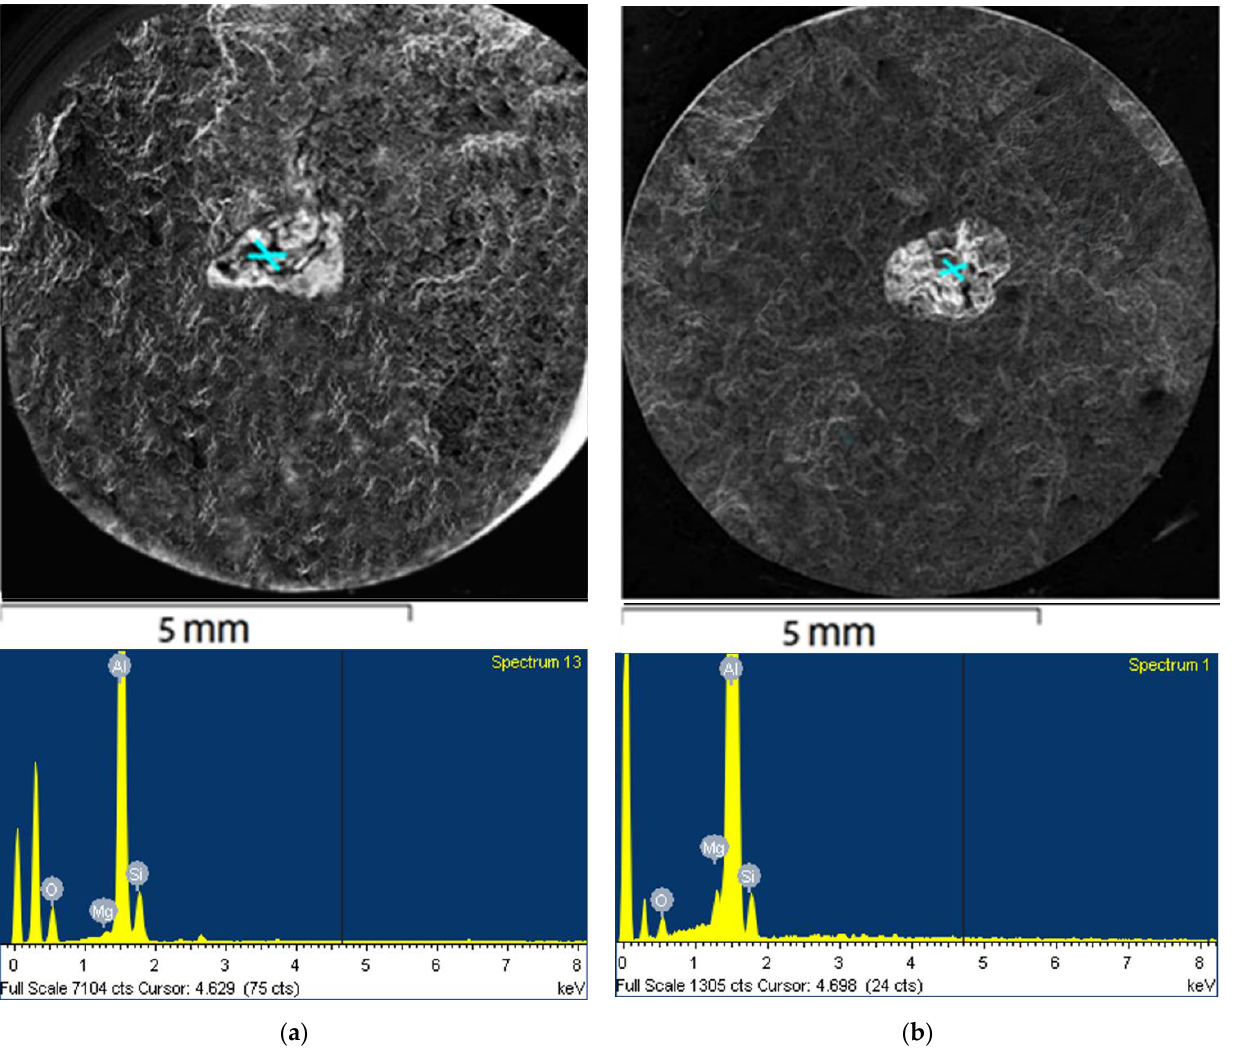
Figure 9. ( a , b ) Electron microscopy fractographs and corresponding EDX spectra (at the positions pointed with “X”) of oxide films on the fracture surfaces of two tensile-tested bars from Experiment 4.